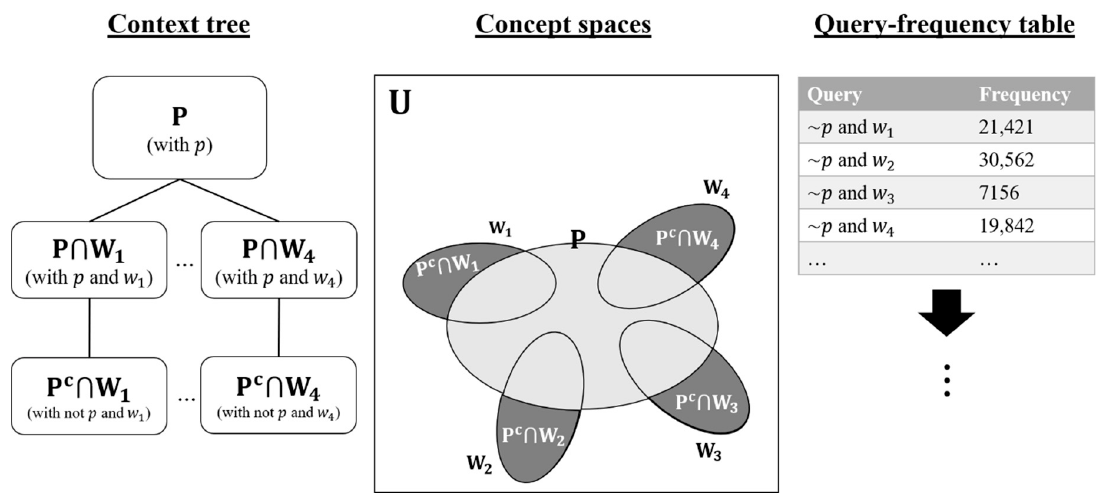
Figure 4. Discovering contexts used for expanding the concept space of the target product.